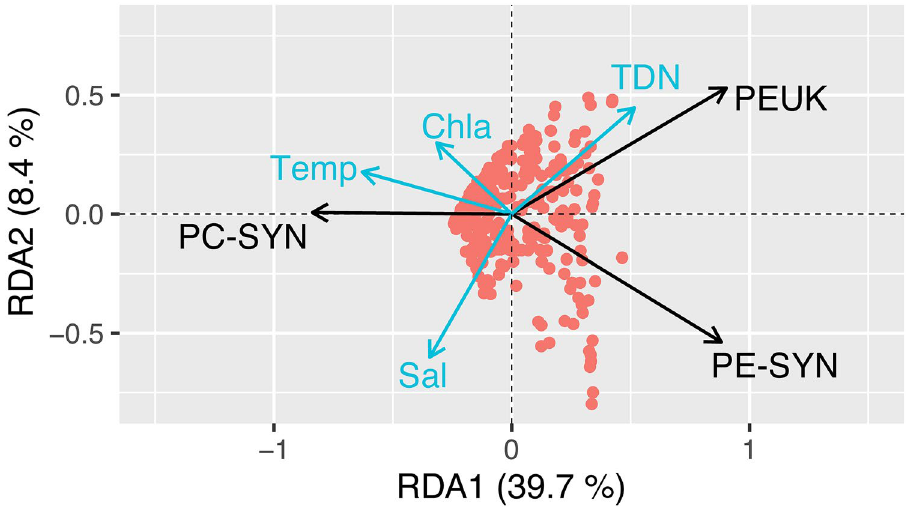
Figure 7. Correlation triplot from the transformed based-redundancy analysis (tb-RDA) explaining observed PicoP abundances (morphotypes; black vectors) according to environmental factors (blue vectors). Samples are represented by red circles. The triplot was interpreted as a “scaling 2—correlation biplot” where angles between variables (explanatory and/or response variables) reflect their correlations. Ordination axes were rescaled to range from − 1.5 to 1.5. All blue arrows are significant factors (Monte Carlo permutation test after a forward selection with Bonferroni’s correction, P value ≤ 0.01). Abbreviations: Temp (Temperature), Chla (Chlorophyll a concentration), Sal (Salinity), and TDN (Total Dissolved Nitrogen concentration). R 52 was used to generate the triplot and color modifications were made in Adobe Illustrator